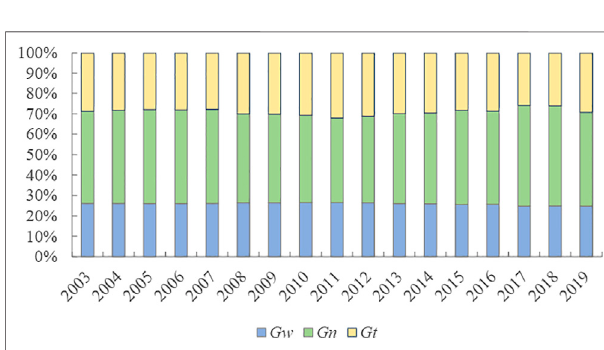
Frontiers in Environmental Science |